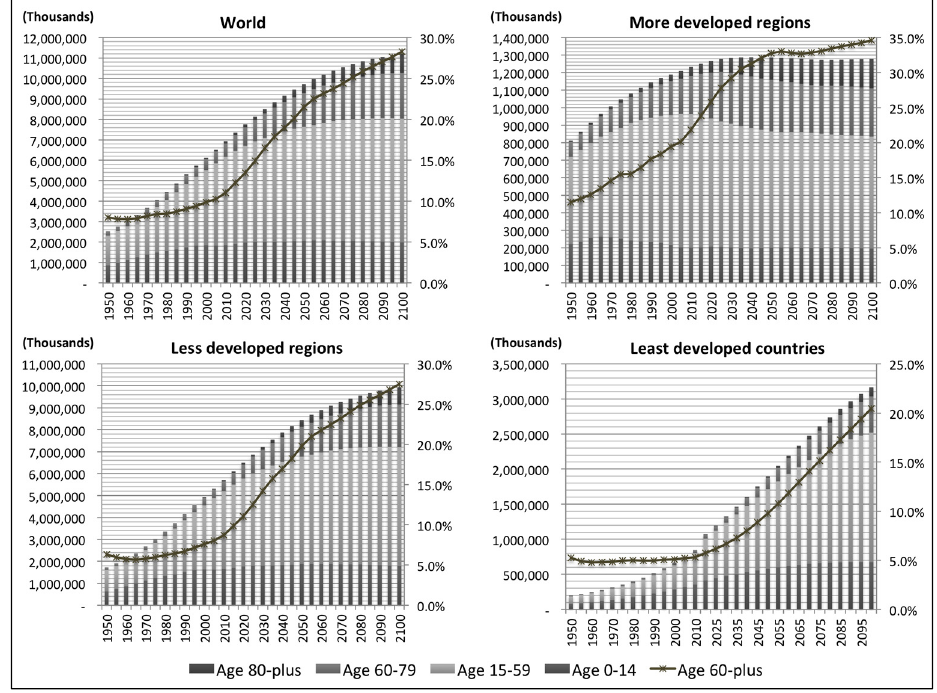
Figure 1. Population trends of the world and three sub-groups with four age groups and the shares of the aged 60-plus population. Note: Created from population estimations for 1950–2010 and population projections with a medium fertility rate for 2015–2100 by the United